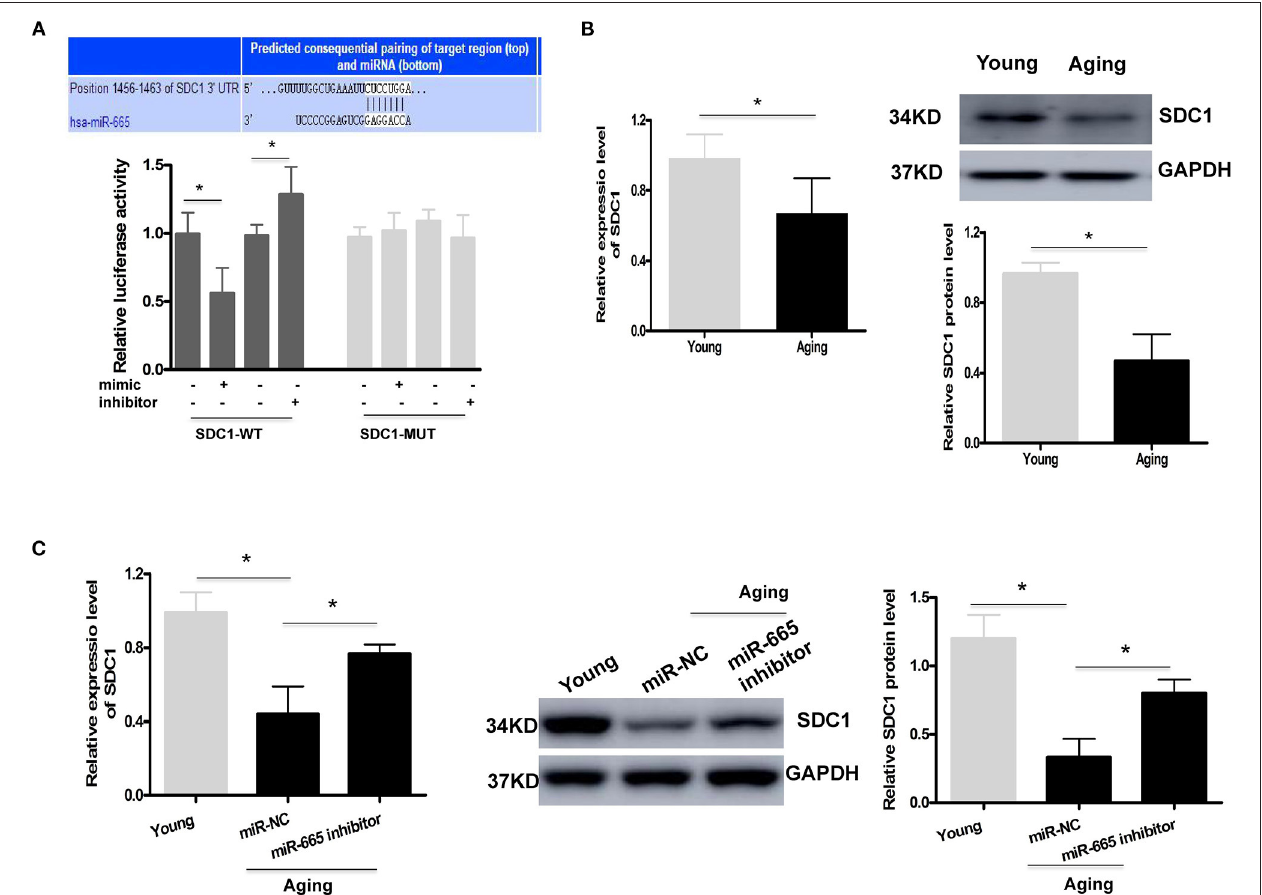
FIGURE 3 | SDC1 functions as a target of miR-665 in VSMCs. (A) Representative predicted binding region of miR-665 and SDC1 and relative luciferase activity determined by dual luciferase reporter assay. * P < 0.05. (B) Representative qRT-PCR and Western blot assays of SDC1 in young and aging VSMCs. * P < 0.05. (C) Representative qRT-PCR and Western blot assays of SDC1 in young and aging VSMCs transfected with miR-665 inhibitor or miR-NC. * P <